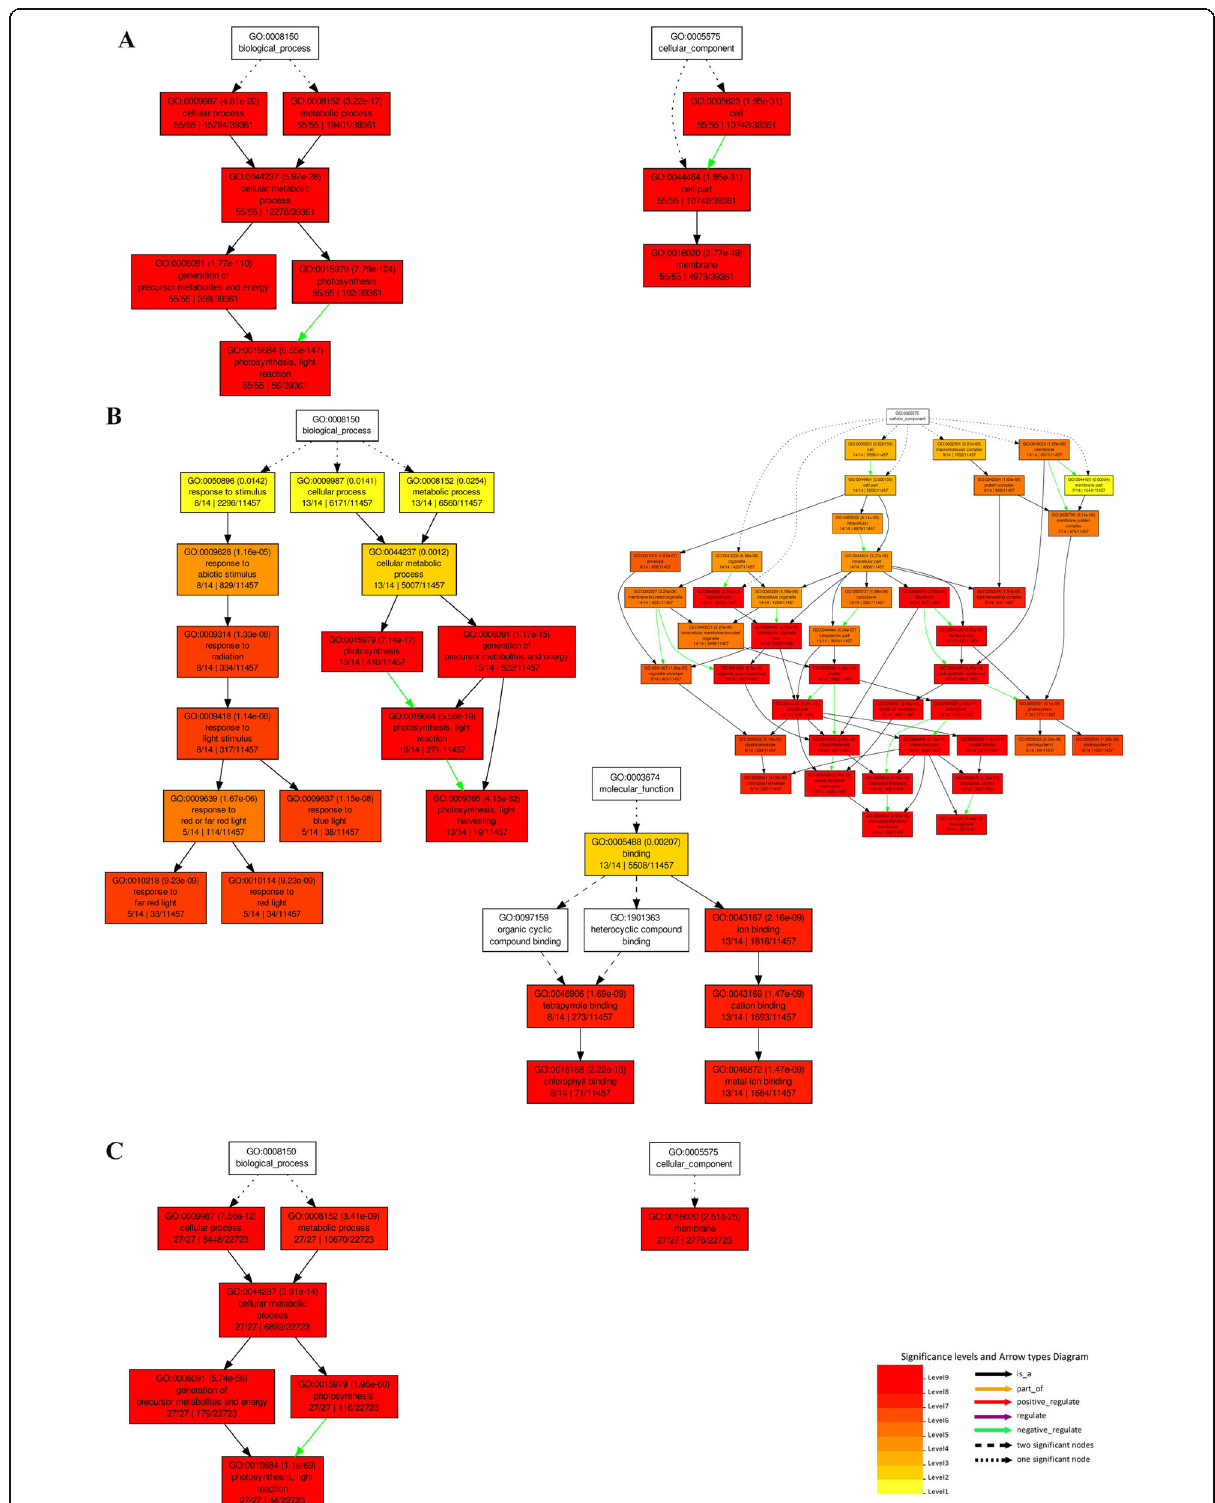
Fig. 2 Gene Ontology annotation analysis of LHC genes, showing their role in biological processes, cellular component and molecular function a G. hirsutum b G. arboreum c G.